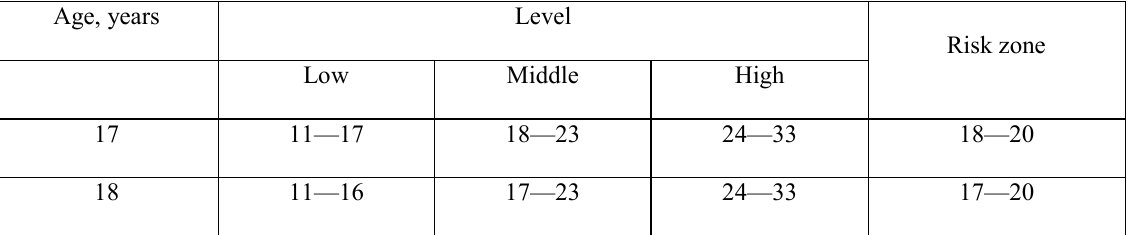
Determination of level of bio-geometrical profile’s state and “risk zones” by integral mark of 17-18 years’ age